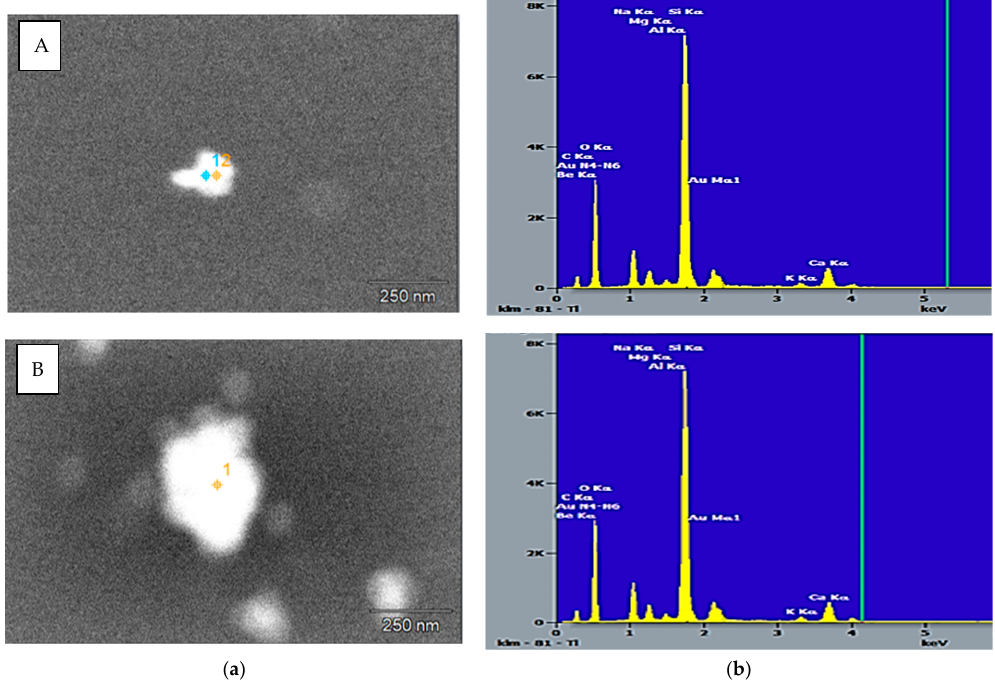
Figure 8. SEM images ( a ) and elemental spectra ( b ) of AuNPs synthesized by R. erythropolis IEGM 766 (A) and R. ruber IEGM 1135 (B) . 1, 2—electron probe markers.